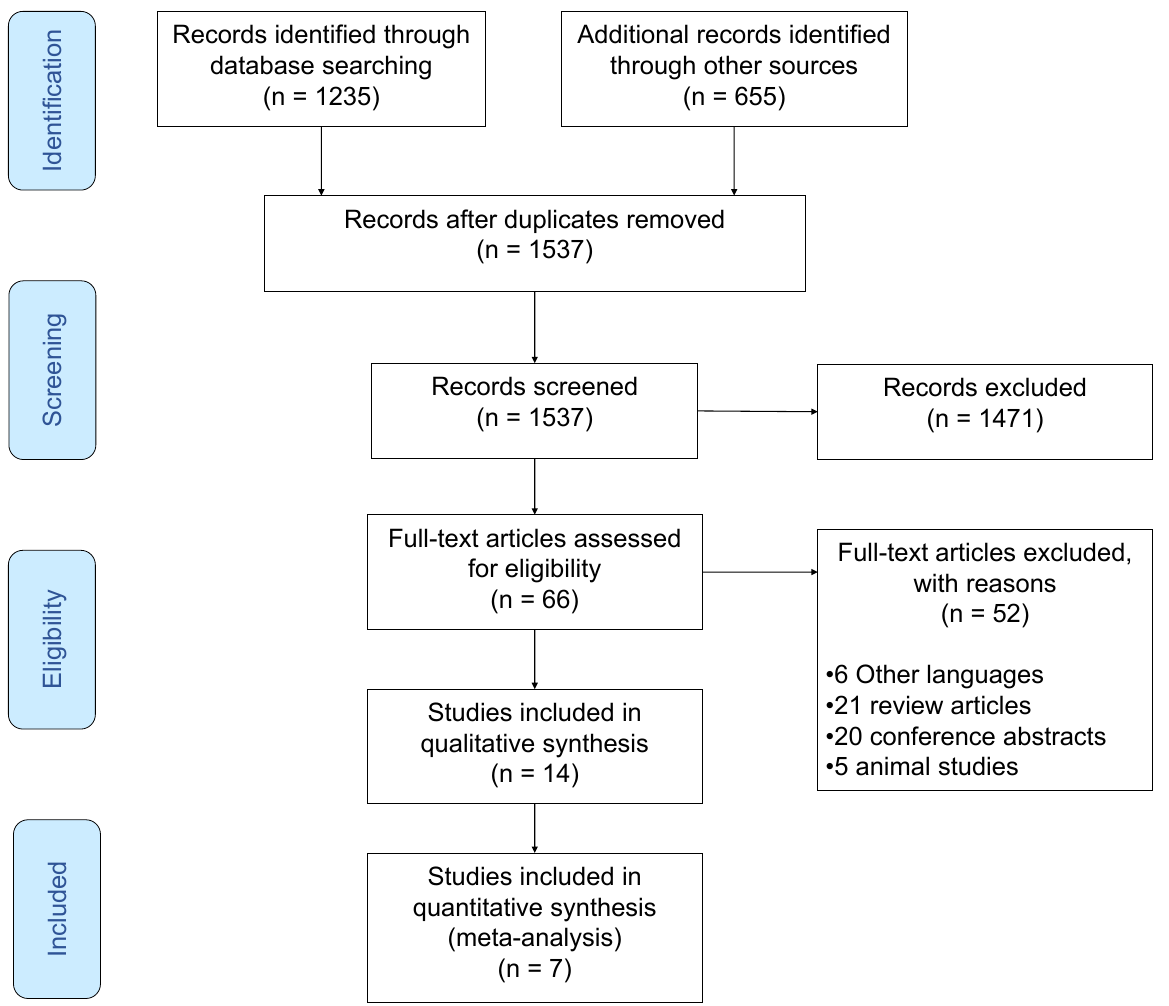
Figure 1. PRISMA flow